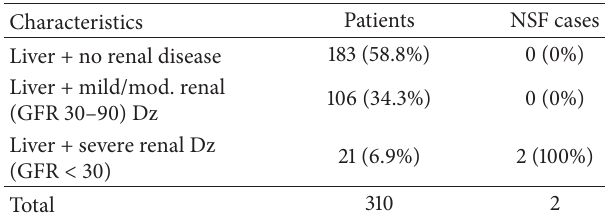
Table 4: Table 4 demonstrates the association of NSF in patients with liver disease and varying degrees of renal failure. The mild to moderate renal group that the Gd warning label targets had 0 cases of